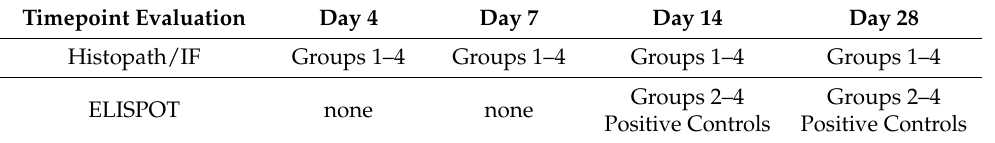
Table 2. Evaluation time